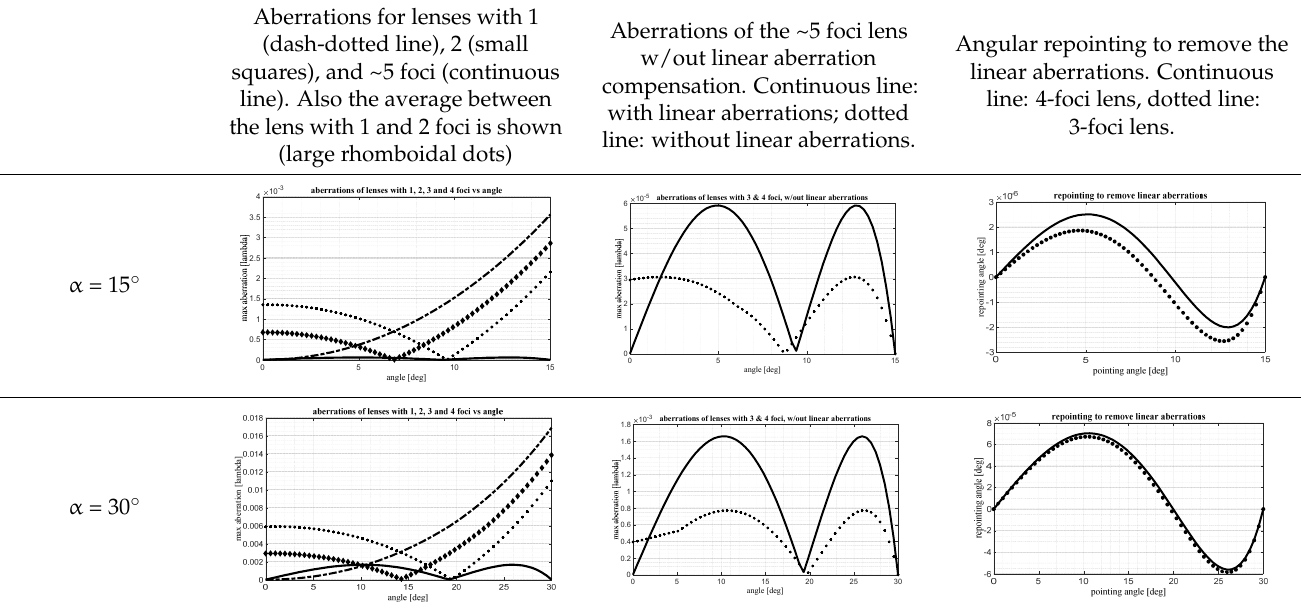
Table 2. Comparison between maximum aberrations of lenses with 1, 2, ~5 foci. F/D = 1, M = 1; axis. The configuration average between the 1- and 2-focus lenses (large rhomboidal D = 30 λ . points) presents intermediate results. The continuous line refers to the ∼ 5-foci lens. For low values of α , the ∼ 5-foci lens performs much better. For α approaching 60°, the perfor- mance is comparable up to a certain angle. However, for angles approaching α , the ∼ 5- foci lens remains significantly better because is able to perfectly cancel the aberrations in α . Table 4 reports the maximum aberrations normalized to the focal distance for discrete lenses having F/D = 1 and M = 1. lenses having F/D = 1 and M = 1. lenses having F/D = 1 and M = 1. Table 3. F/D = 1, M = 1; D = 30 λ. Table 3. F/D = 1, M = 1; D = 30 λ . Table 3. F/D = 1, M = 1; D = 30 λ. Table 3. F/D = 1, M = 1; D = 30 λ. Aberrations of the ∼ 5 foci lens w/out Aberrations for lenses with 1 (dash- Aberrations of the ∼ 5 foci lens w/out Aberrations of the ∼ 5 foci lens w/out linear aberration compensation. Angular repointing to remove the dotted line), 2 (small squares), and linear aberration compensation. Angular repointing to remove the linear aberration compensation. Angular repointing to remove the Continuous line: with linear aberra- linear aberrations. Continuous line: ∼ Continuous line: with linear aberra- linear aberrations. Continuous line: Continuous line: with linear aberra- linear aberrations. Continuous line: tions; dotted line: without linear ab- 4-foci lens, dotted line: 3-foci lens. tions; dotted line: without linear ab- 4-foci lens, dotted line: 3-foci lens. tions; dotted line: without linear ab- 4-foci lens, dotted line: 3-foci lens. errations. errations. errations. dal dots) dal dots)